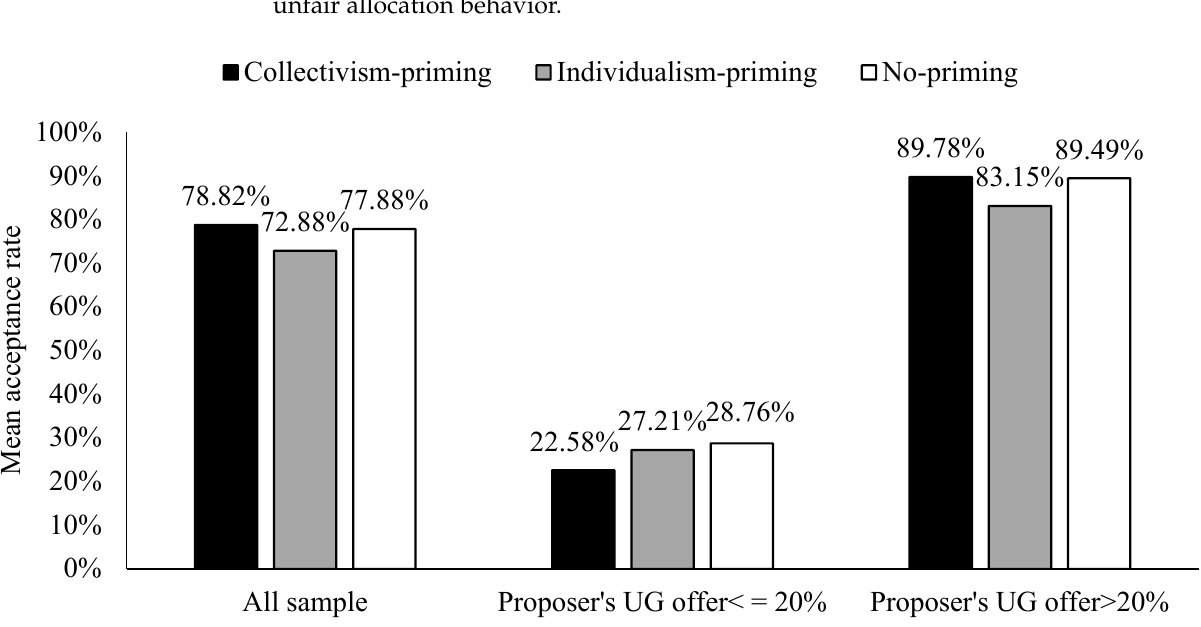
Figure 4. Comparison of mean acceptance rate.